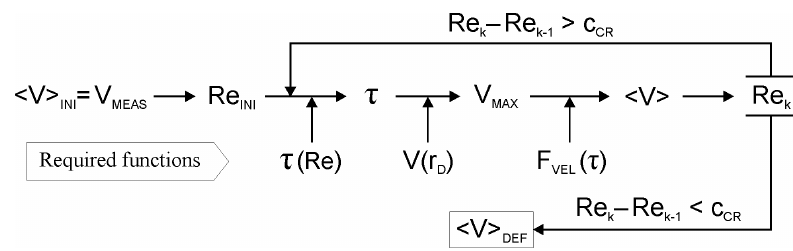
Figure 2. Flowchart of flowmeter log